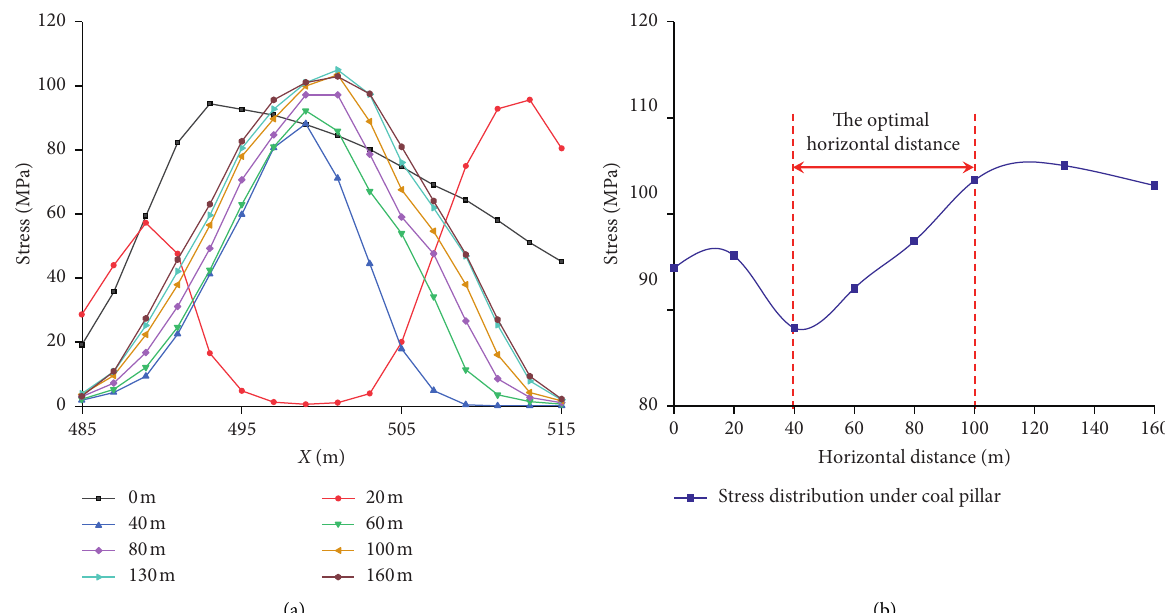
Figure 9: The distribution of vertical stress in the zone of influence of the remaining coal pillar during mining under different horizontal distances L . (a) Vertical stresses in the area of influence of the remaining coal pillar under different values of L . (b) The vertical peak stress in the zone of influence of the remaining coal